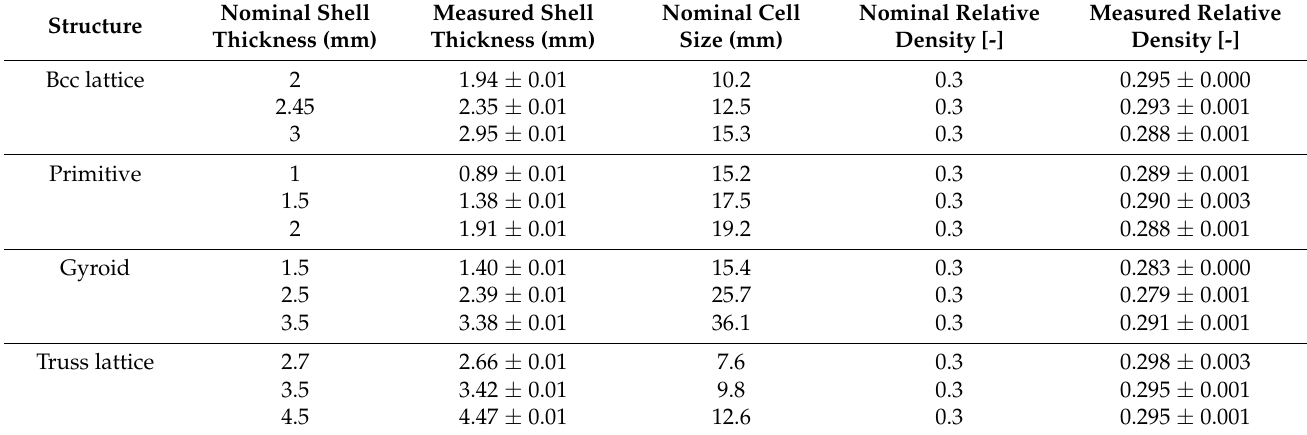
Table 2. The specific parameters of the structure used in this study. Figure 2. Structure diagram of each unit ( a ) and actual printed solid parts ( b ), from left to right, there are Bcc lattice, Primitive, Gyroid, and truss lattice.